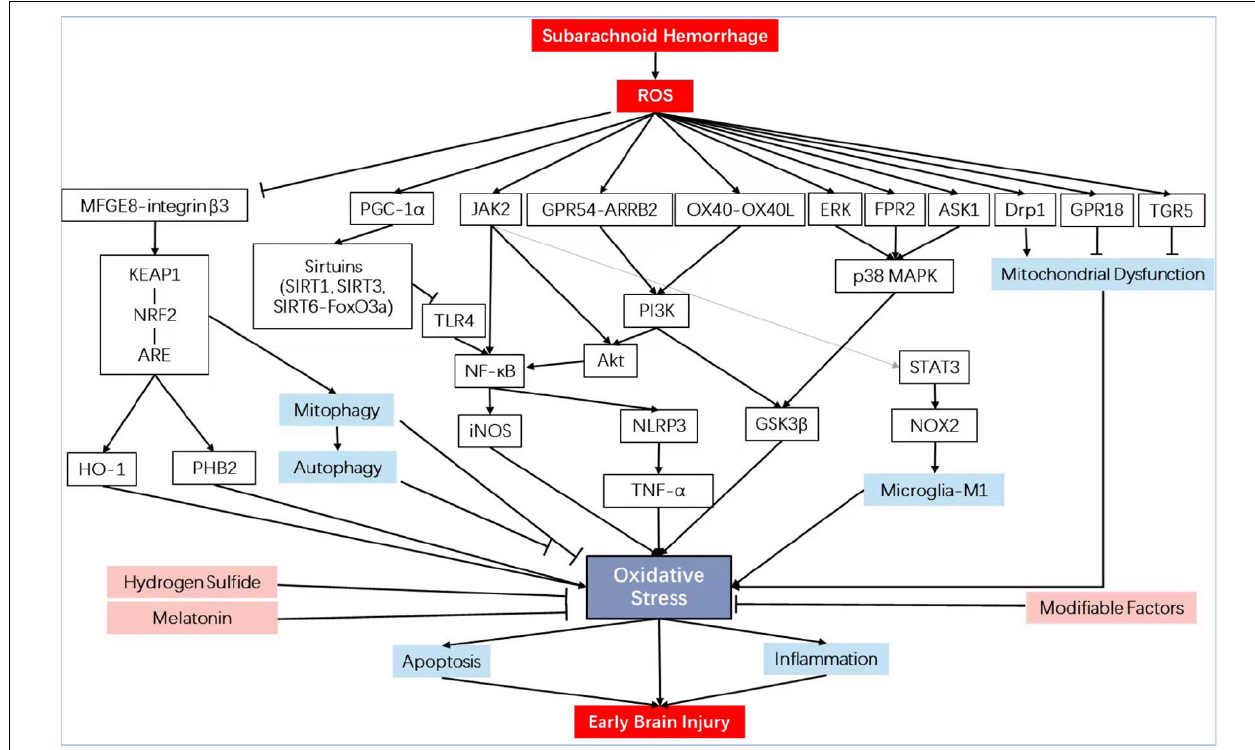
FIGURE 1 | Schematic diagram illustrating the signaling pathways involved in oxidative stress in early brain injury. iNOS, inducible nitric oxide synthase; PHB2, prohibitin 2; NRF2, nuclear factor erythroid 2-related factor 2; HO-1, heme oxygenase-1; NF- κ B, nuclear factor kappa-B; KEAP1, Kelch-like epichlorohydrin-associated protein 1; ARE, antioxidant response element; MFGE8, milk fat globule–EGF factor-8; TLR4, toll-like receptor 4; TNF- α , tumor necrosis factor- α ; GPR18, G protein-coupled receptor 18; p38 MAPK, mitogen-activated protein kinase; FPR2, formyl peptide receptor 2; ASK1, apoptosis signal-regulating kinase 1; Drp1, dynamin-related protein 1; OX40L, OX40 cognate ligand-protein; GPR54, G protein-coupled receptor 54; ARRB2, β -arrestin 2; GSK3 β , glycogen synthase kinase-3 β ; PI3K, phosphatidylinositol 3-kinase; TGR5, trans-membrane G protein-coupled receptor-5; PGC-1 α , peroxisome proliferators-activated receptor- γ coactivator-1 α ; NLRP3, NLR family, pyrin domain containing